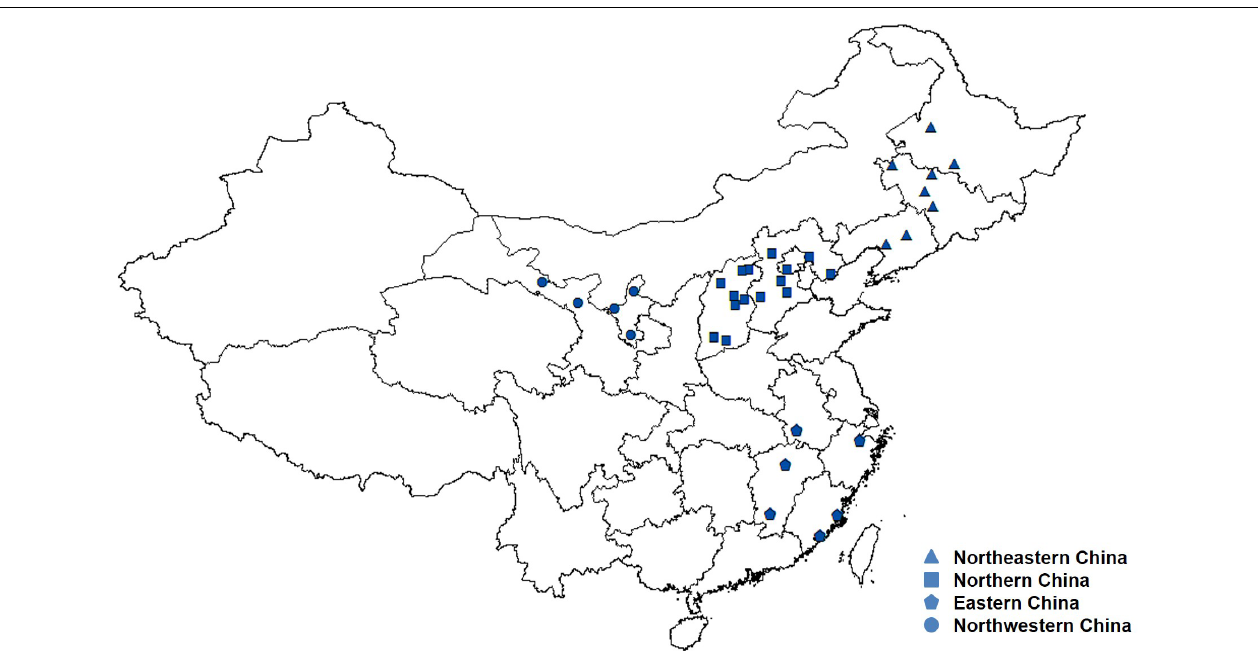
FIGURE 1 | Geographic locations of the four tomato cropping regions of Alternaria tenuissima used in the study.